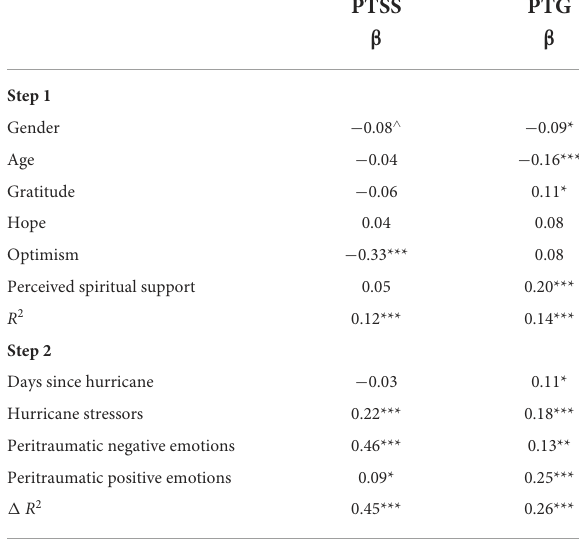
TABLE 1 Hierarchical regression on post-traumatic stress and post-traumatic